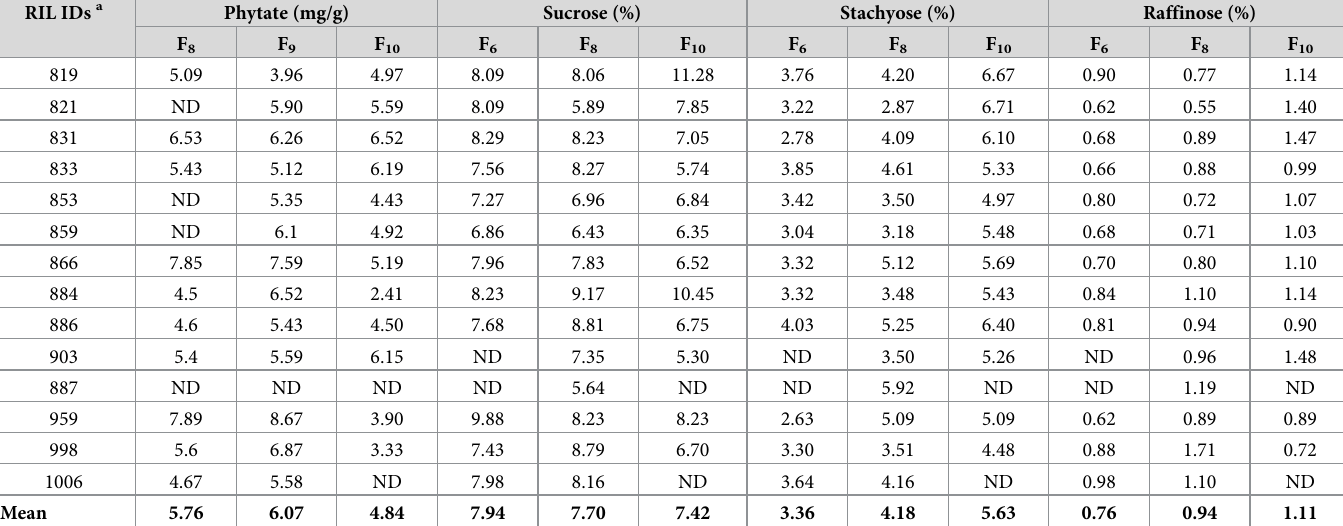
Table 3. Recombinant inbred lines in the mips/mrp-l/mrp-n genotypic class of the V99-5089 x CX1834